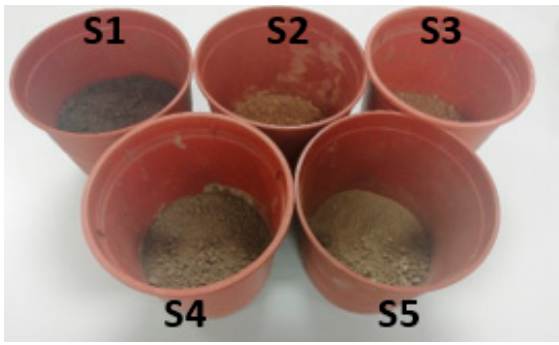
Figure 6. S1 to S5 soils: S1 to S3 in the upper row, S4 and S5 on the lower row.